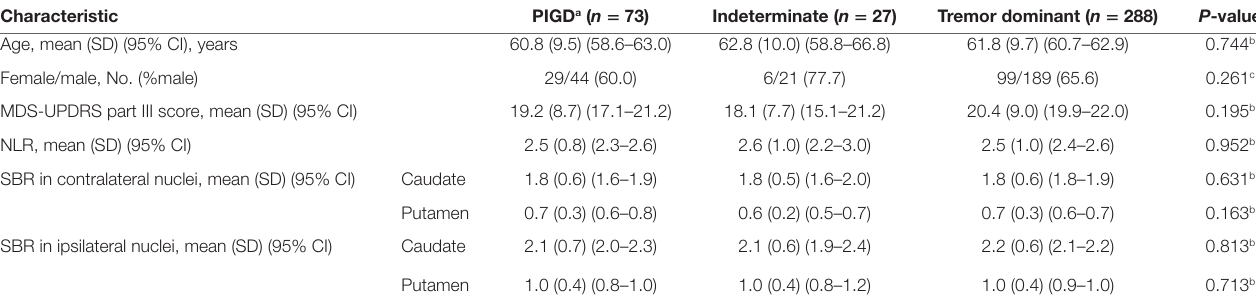
TaBle 2 | Demographic data and comparison of certain characteristics between patients with Parkinson’s disease (PD) based on tremor/postural instability and gait difficulty (PIGD) score